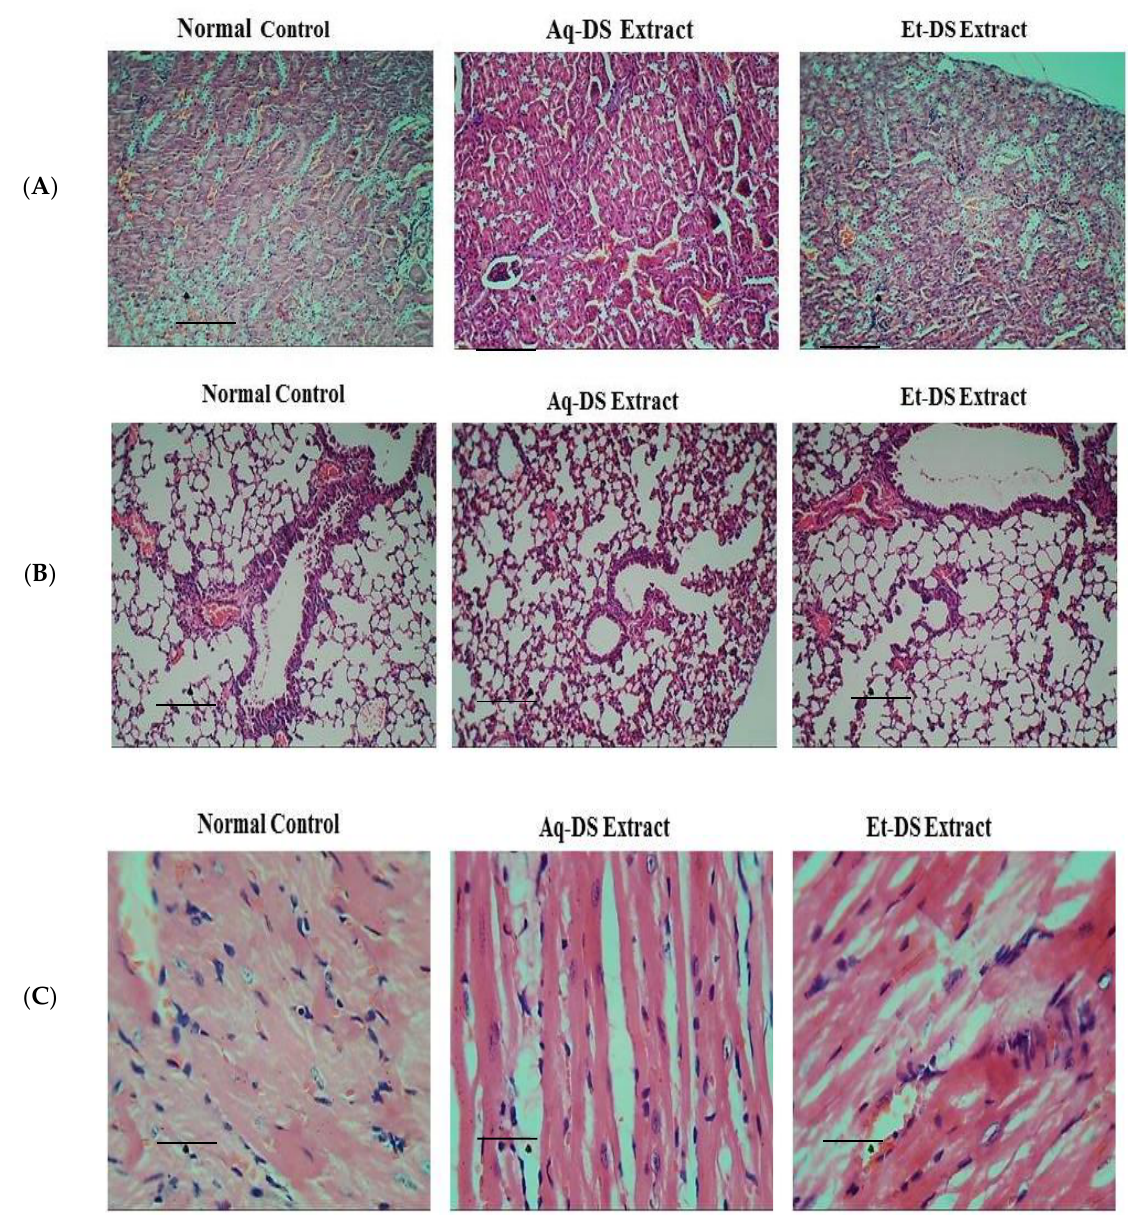
Figure 3. Histopathological photomicrographs of normal control, Aq-DS (aqueous extract of DS group) and Et-DS (ethanolic extract of DS group) extracts administered at 500 mg/kg, single dose in ( A ) Kidney, normal structures of renal corpuscles and renal tubules without pathological signs are visible in Hematoxylin and Eosin stained sections (5 µm thick) at 40× magnification; ( B ) Normal histology of lung showing bronchioles and alveoli without pathological signs in Hematoxylin and Eosin stained sections (5 µm thick) at 40× magnification; ( C ) Clear cardiac muscle fibers without pathological signs are evident in Hematoxylin and Eosin stained sections (5 µm thick) at 40×. Scale Bars: ( A , B ) = 1.5 cm, ( C ) = 0.8 cm.